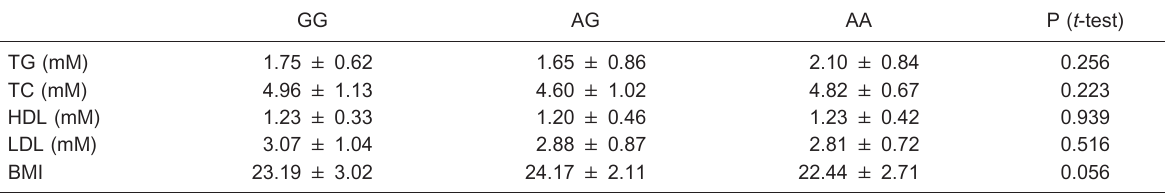
Table 6. Association of rs1761667 polymorphism with clinic indexes in the coronary artery heart disease